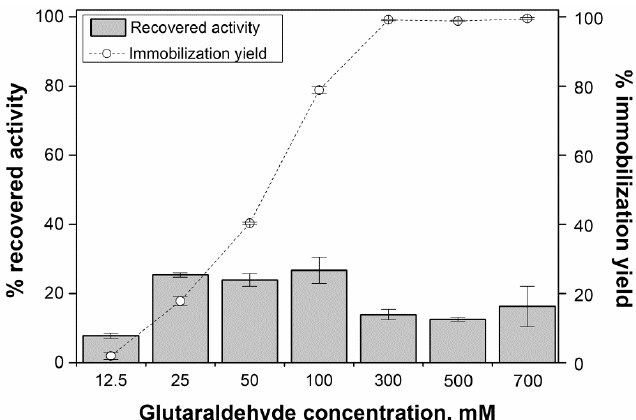
Figure 9. Effect of glutaraldehyde concentration on CLEA of amyloglucosidase (AMG) synthesized in the presence of polyethyleneimine (PEI) and co-aggregated with the magnetic nanoparticles DCNP-N and starch 1% ( w / v ). Synthesis conditions: treatment of AMG with PEI/enzyme mass ratio of 1:1 (30 min under gently stirring at 25 ◦ C), co-aggregation with DCNP-N/enzyme mass ratio of 1:1, ethanol/enzyme solution (in 100 mM phosphate buffer pH 7.0) volume ratio of 9:1, crosslinking with glutaraldehyde concentrations ranging from 100 to 700 mM, precipitation and crosslinking under static conditions in an ice bath. Activity of immobilized AMG was measured with 1% ( w / v ) dextrin in 50 mM sodium citrate buffer pH 4.5, 10 min reaction at 55 ◦ C under 900 rpm stirring. Values are shown as the mean of duplicate experiments ±